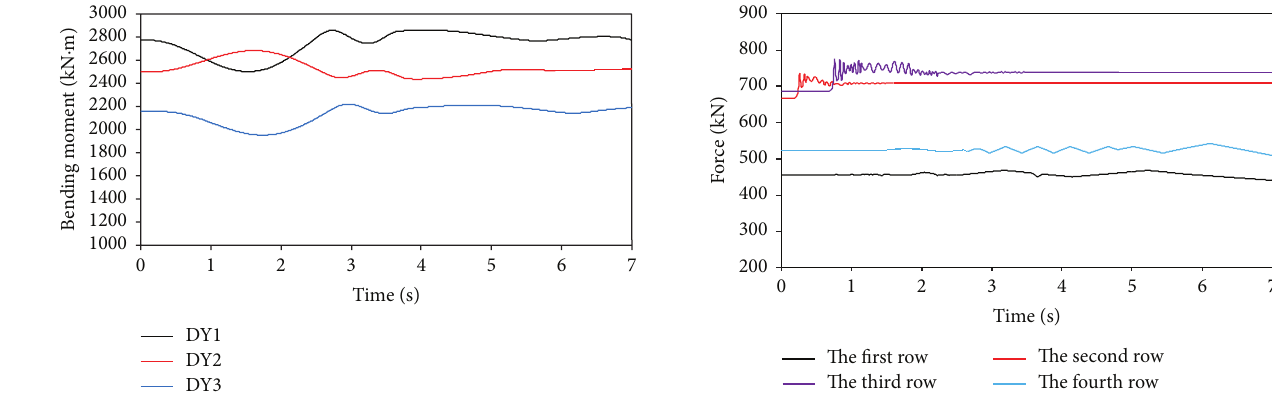
Figure 11: Time history curve of pile bending moment at the monitoring points monitoring site DY1 (black), monitoring site DY2 (red), and monitoring site DY3 (blue).